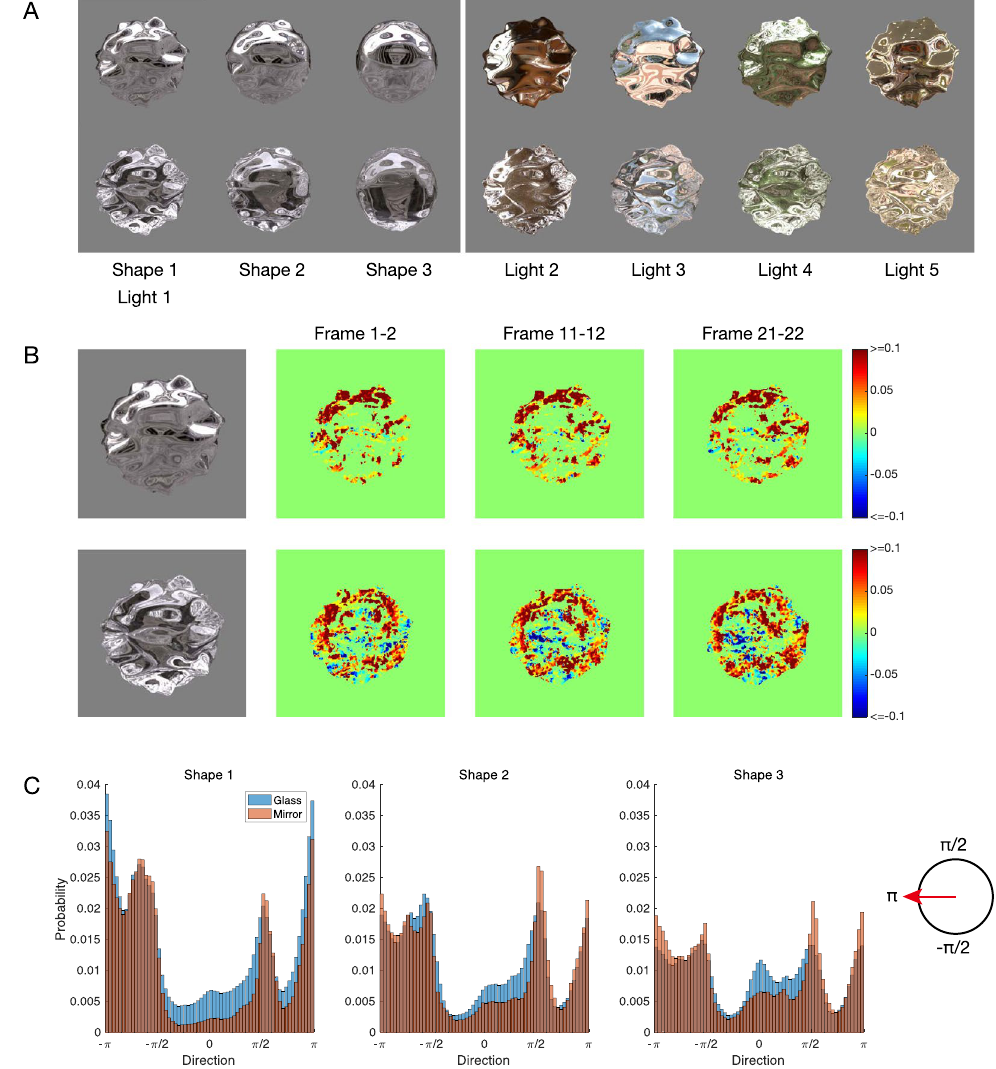
Figure 1. Differences between mirror and glass materials in video stimuli. ( A ) Examples of stimuli (see Movie 1 for the dynamic condition). The top row contains the mirror material objects and the bottom row contains the glass material objects. The left block shows three different shapes under illumination 1 (environment light field). The right block shows five different illuminations with object shape 1. ( B ) Visualisations of motion components in object rotation direction. The top column shows the mirror material objects and the bottom column shows the glass material objects. Colour maps indicate the magnitude of the motion components in each pixel. Red indicates the left direction and blue indicates the right direction. We selected three examples, frames 1–2, 11–12, and 21–22, for shape 1 under illumination 1. ( C ) Histogram indicating the directions motion of the optic flows of mirror and glass materials. The horizontal axis indicates the direction in radians (right is zero and left is pi). The vertical axis indicates the probability of appearance frequency. The optic flows were included for all frames and the five natural illuminations. Note that these components only move in the horizontal direction because the object was rotated around the vertical